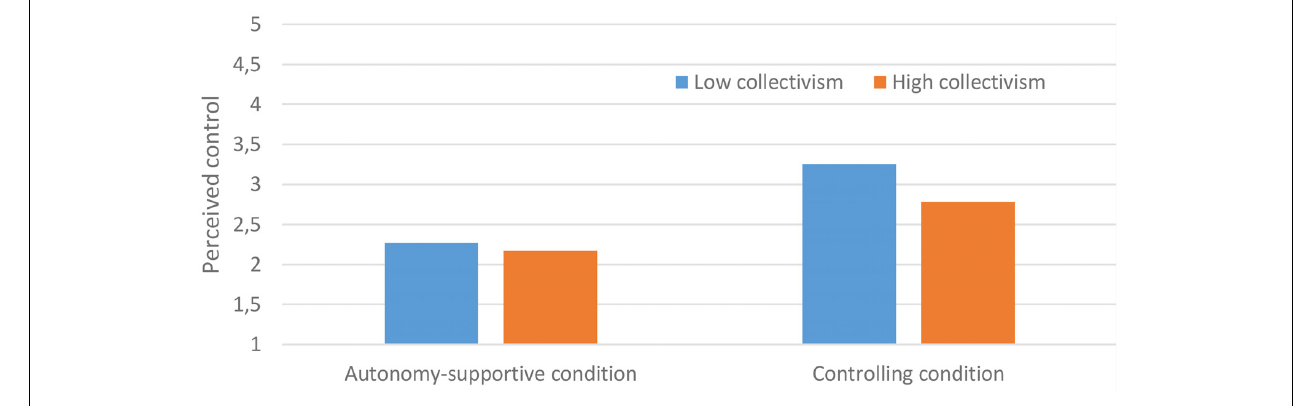
FIGURE 1 | Interaction between collectivism and condition in the prediction of perceived